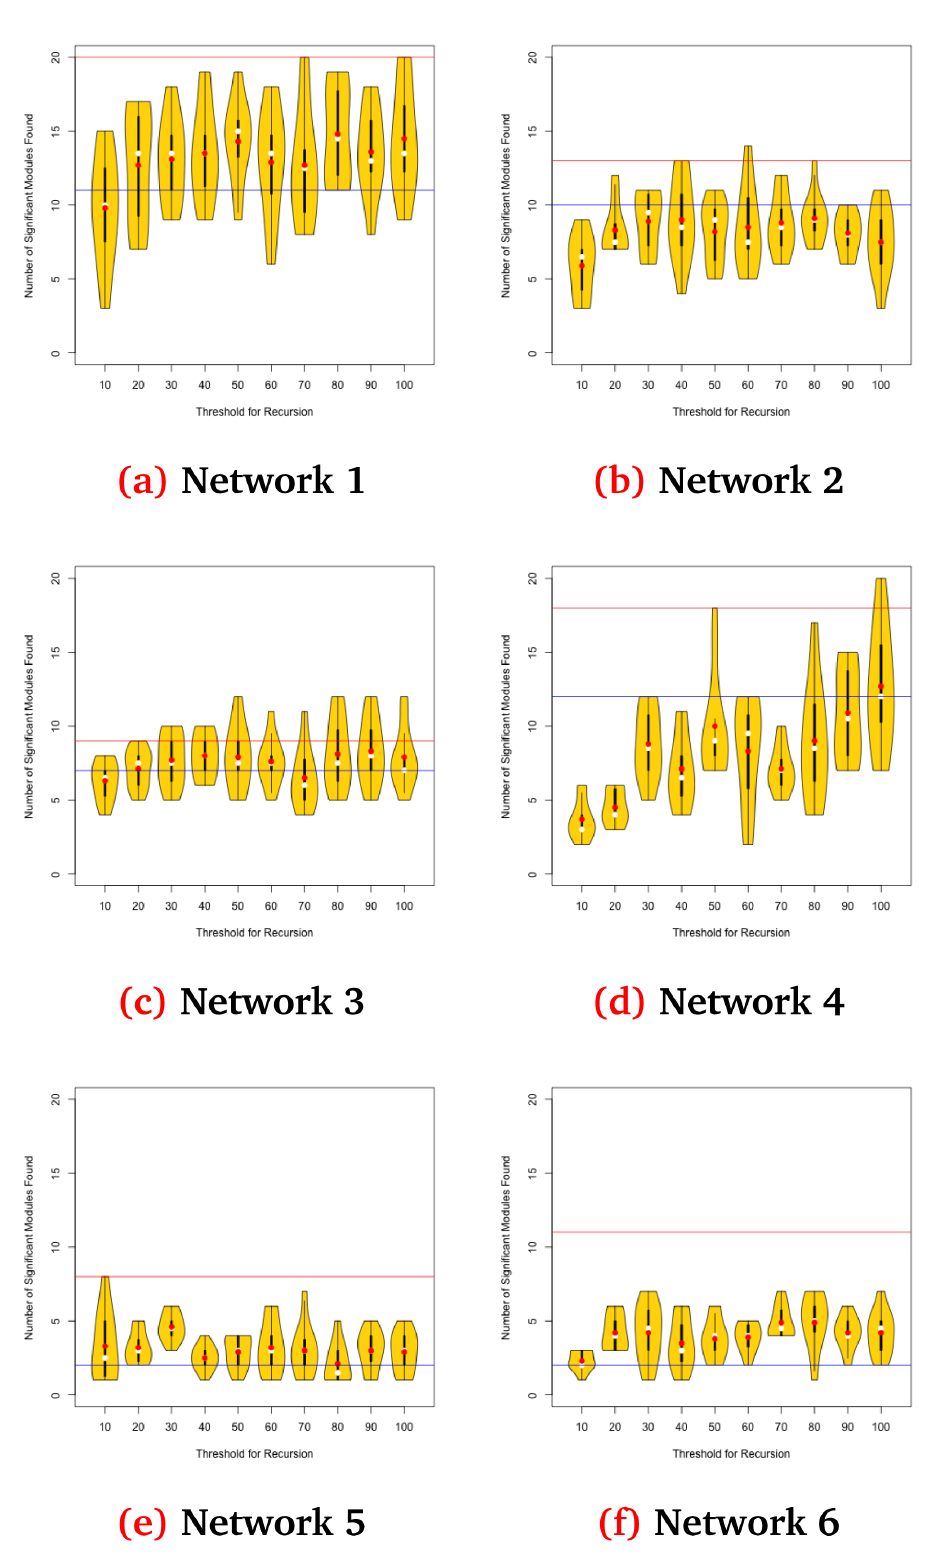
Figure 3. Results on each network as a function of the value for k . White and red dots represent the median and mean values for each configuration, respectively. The blue line indicates our performance in the challenge leaderboard for that network, and the red line that of the best submission for that